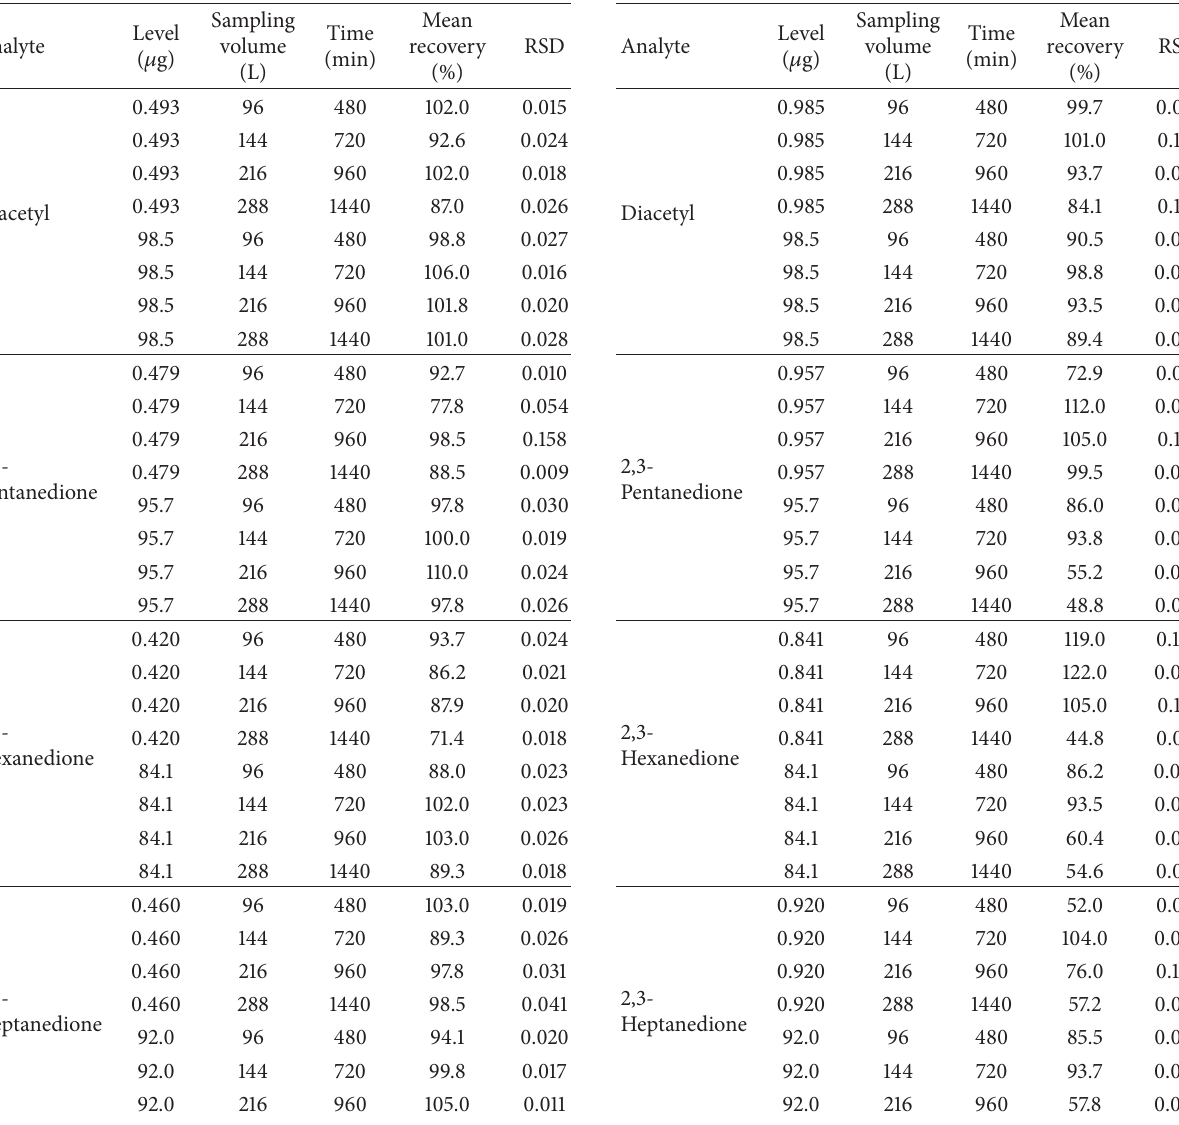
Table 11: Determination of extended air sampling capacity of o - PDA-treated silica gel tubes at 50% relative humidity at 2 concen- tration levels using increased sampling rate (200 cc/min).